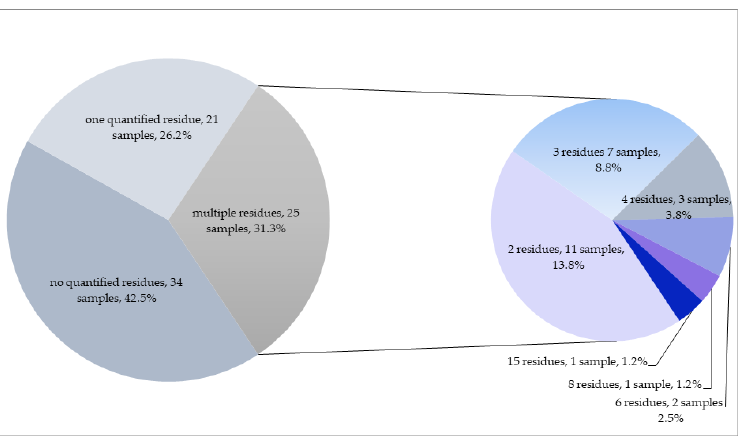
Figure 3. Number of quantified residues in dill samples.